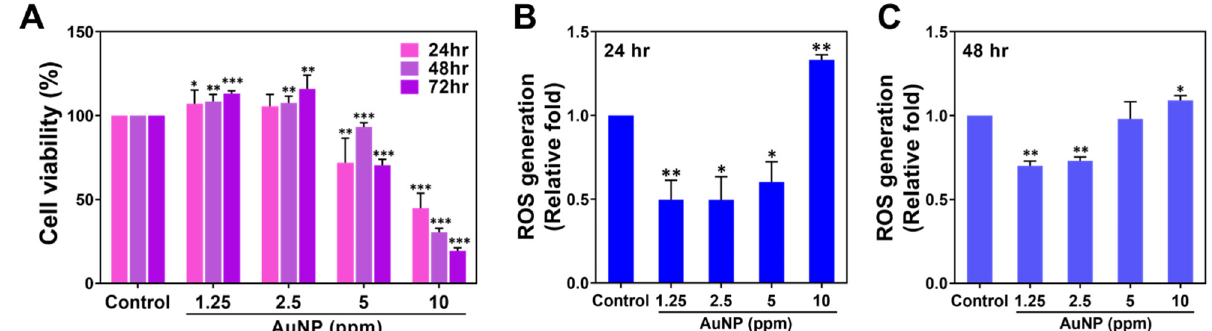
Figure 2. Cell viability and ROS generation of MSCs treated with various concentrations of AuNPs. ( A ) The cell viability of MSCs treated with AuNPs was investigated. The results indicate that the AuNP 1.25 and 2.5 ppm treatments enhanced better MSCs proliferation at 48 and 72 h, while the AuNP 5 and 10 ppm treatments had significantly lower cell viability at each time point. ( B,C ) The intracellular ROS generation in the MSCs was detected using the FACS method after 24 and 48 h of treatment. The results demonstrate that the AuNP 1.25 and 2.5 ppm groups induced lower ROS production at both time points. The results are displayed as mean ± SD ( n = 3). * p < 0.05, ** p < 0.01, *** p < 0.001: compared to the Control group (TCPS).